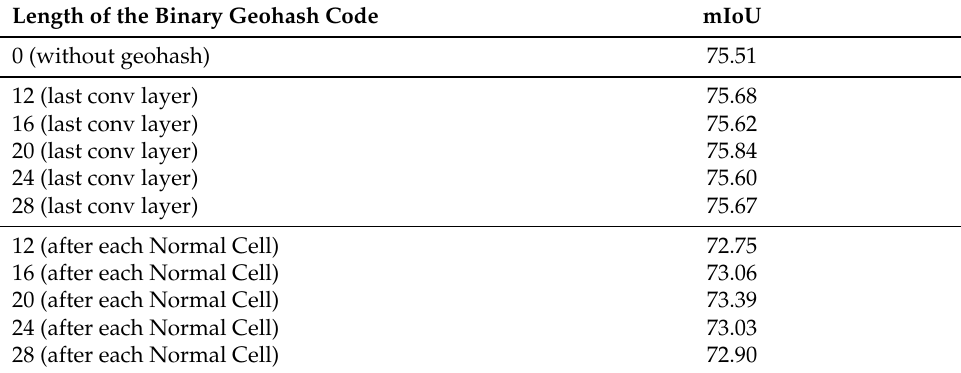
Table 4. Different lengths of the binary geohash on the Inria dataset.